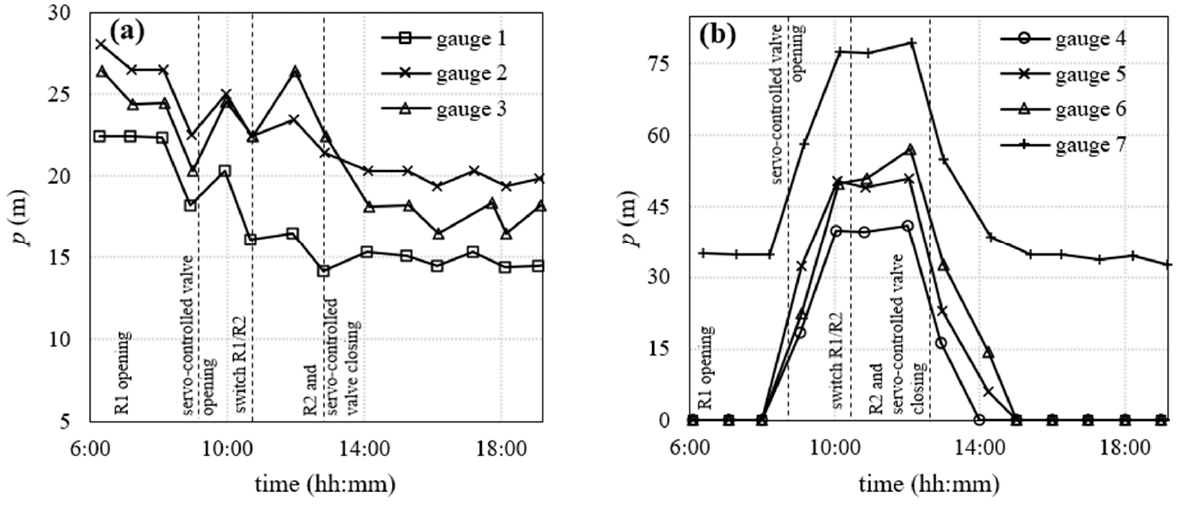
Figure 6. Nodal pressures p at nodes located in the ( a ) high and ( b ) low zone of the WDN during the experiment of Wednesday, 3 July 2019.